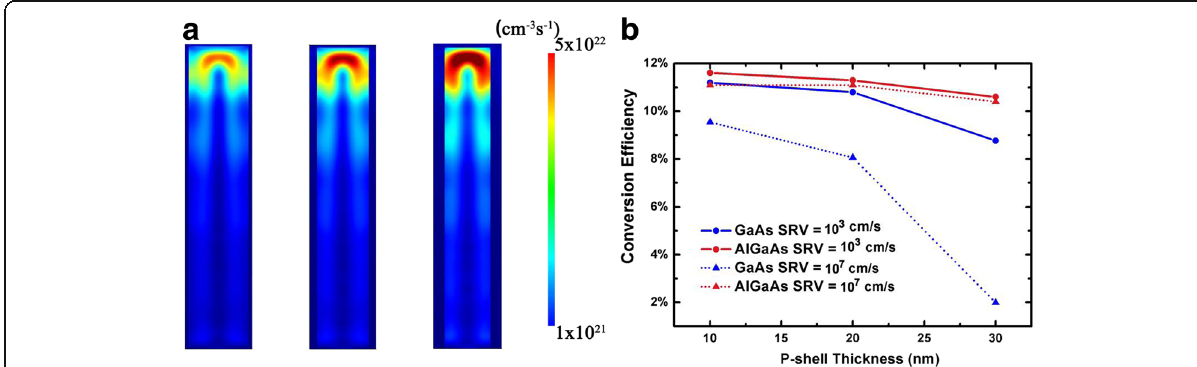
Fig. 5 a The vertical cross section of optical generation profiles in AlGaAs/GaAs nanowire radial pin heterojunction solar cells with different p -shell thicknesses. b The conversion efficiency of GaAs and AlGaAs/GaAs nanowire radial solar cells as functions of p-shell